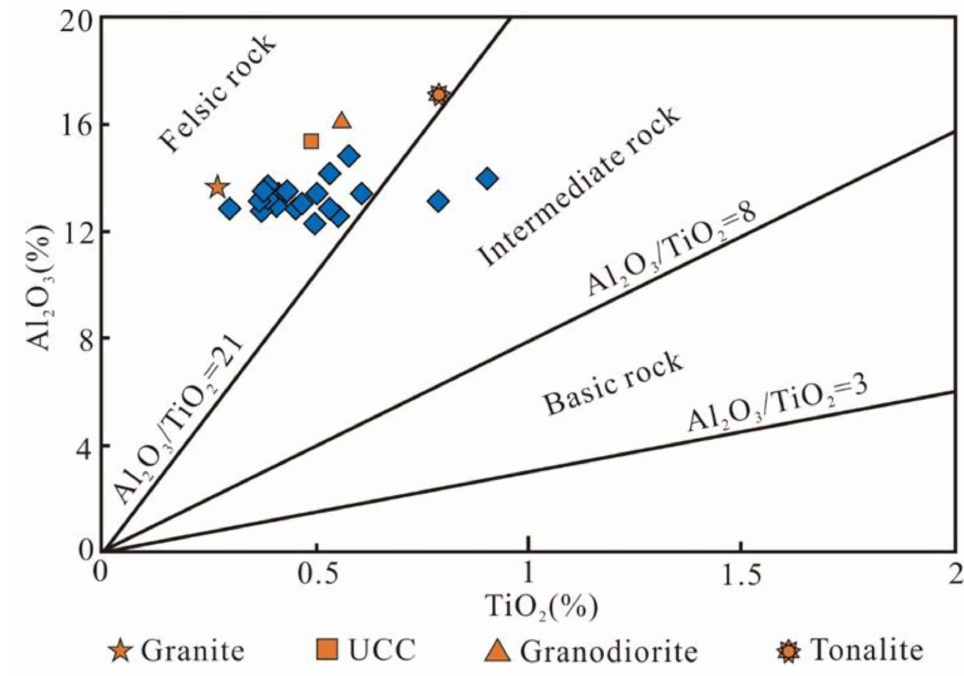
Figure 8. The plot of Al 2 O 3 versus TiO 2 [19] of the Zhiluo Formation sandstones: UCC [39], gran- ite [40], granodiorite [41] and tonalite [41]. The K 2 O versus Rb diagram and TiO 2 versus Ni diagram (Figure 9) can be used to distinguish the composition of the source area [42,43]. In the K 2 O versus Rb diagram (Figure 9a), all samples in the study area plot within the area with the field of intermediate to felsic rock, and in the TiO 2 versus Ni diagram (Figure 9b), the sandstone samples are mainly concentrated in the acidic rock area. The two diagrams show that the source rocks of the Zhiluo sandstone are felsic to intermediate igneous source rocks.